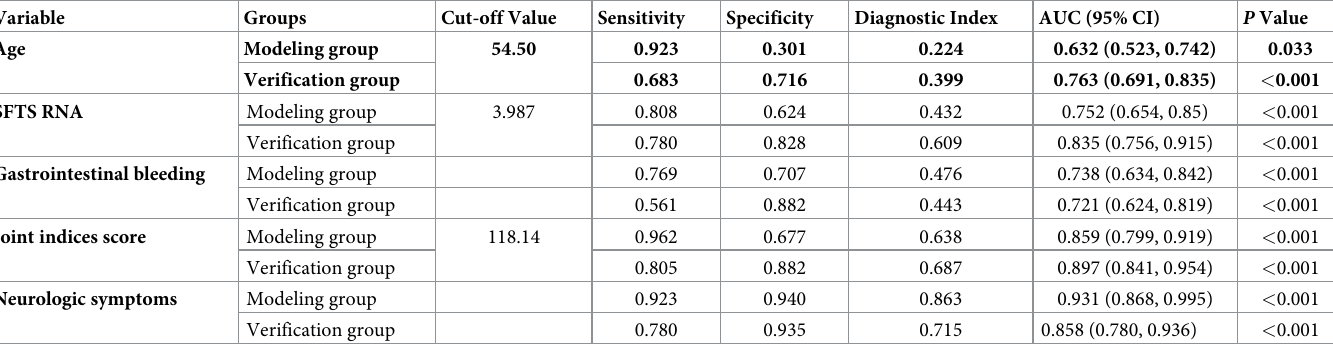
Table 3. Forecast Performance Analysis of Each Index in the Modeling and Verification Groups.